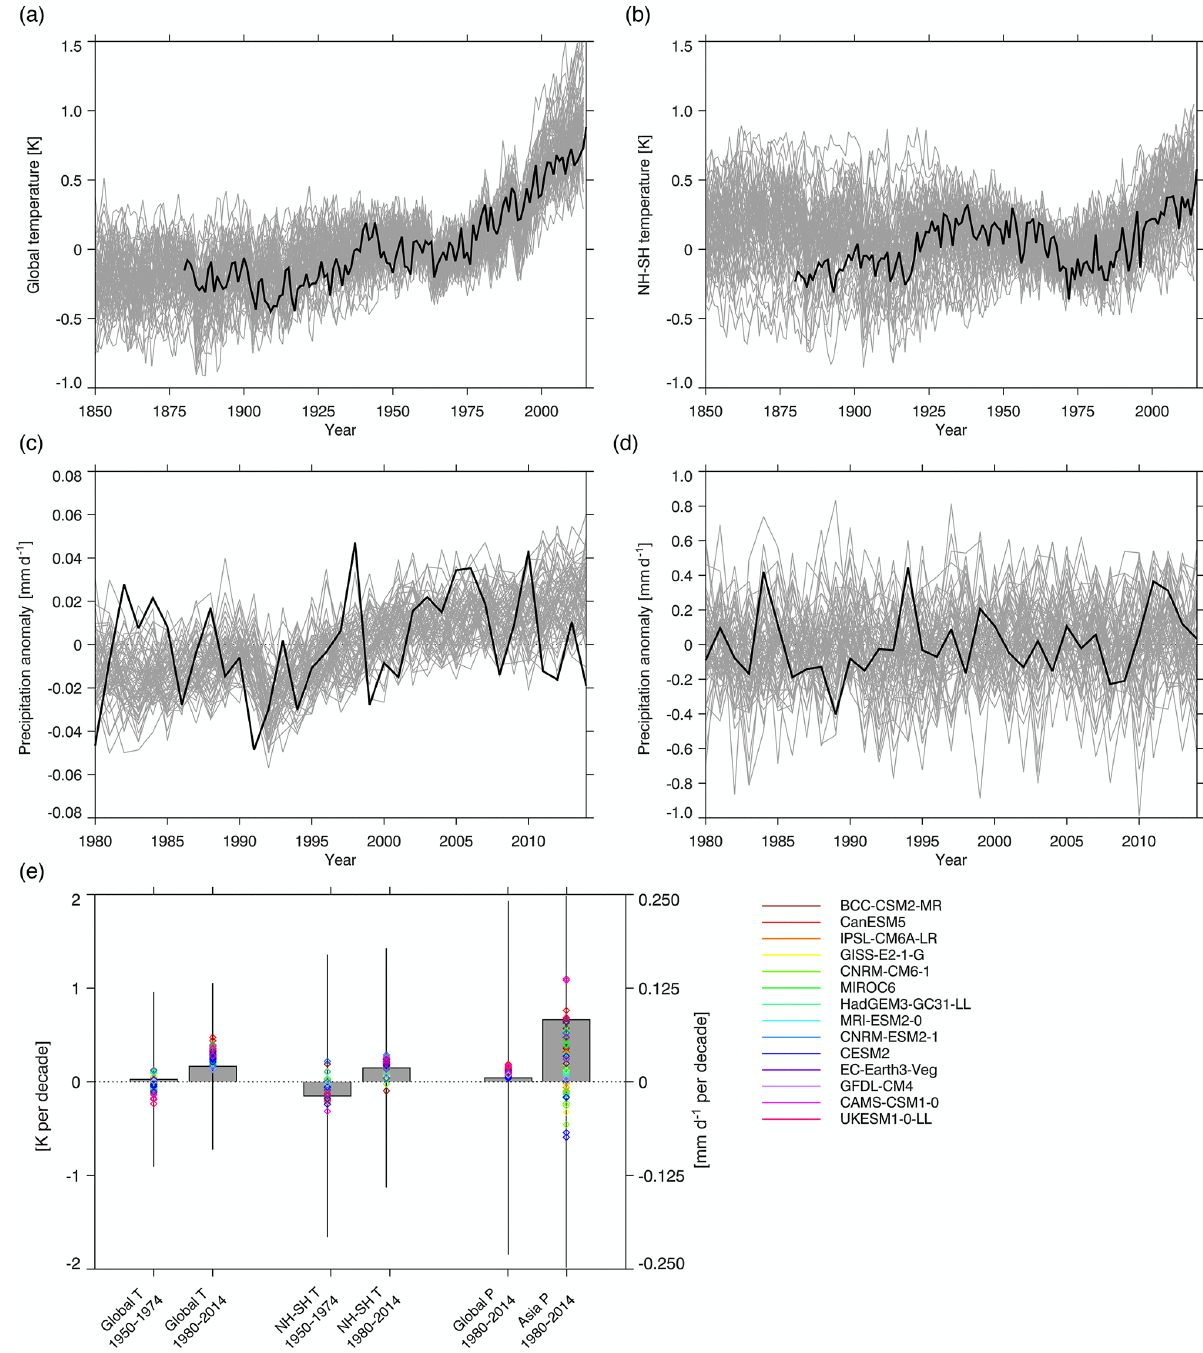
Figure 4. (a) Global-mean annual-mean temperature anomaly relative to 1951–1980 from CMIP6 (grey lines show individual members) and GISTEMP (black). (b) Annual-mean interhemispheric temperature gradient anomaly relative to 1951–1980 from CMIP6 (grey) and GISTEMP. (c) Annual-mean global-mean precipitation anomaly relative to 1980–2014 from CMIP6 (grey) and GPCP (black). (d) JJA-mean Asia-mean precipitation anomaly relative to 1980–2014 from CMIP6 (grey) and GPCP (black). Asia is the region from 5–47.5 ◦ N and 67.5–145 ◦ E. (e) Linear trends in annual-mean global-mean temperature and JJA-mean interhemispheric temperature gradient from CMIP6 (coloured diamonds) and GISTEMP (grey bars) for 1950–1974 and 1980–2014 and linear trends in annual-mean global-mean precipitation and JJA-mean Asia-mean precipitation for 1980–2014 (grey bars are GPCP). Error bars show ± 1SE (standard error) on the observed trend. Note that for Asian precipitation this extends beyond the range of the plot and is an order of magnitude larger than the